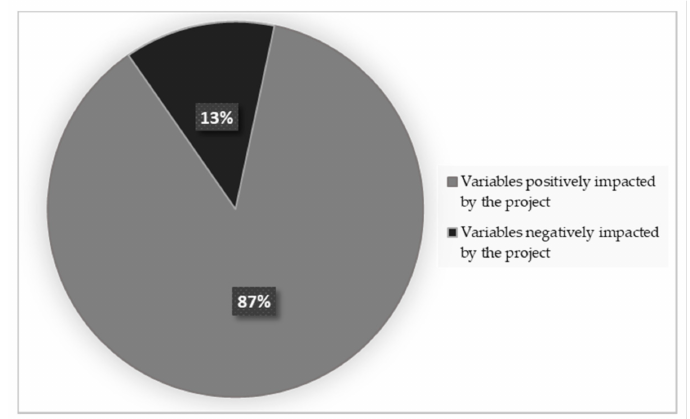
Figure 5. Proportion of variables negatively and positively affected by the PES project.